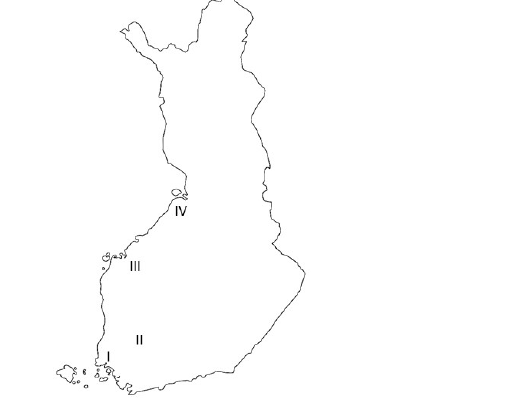
Figure 2. The approximate locations of the observation fields. The Roman numerals refer to the corresponding hardiness zone.